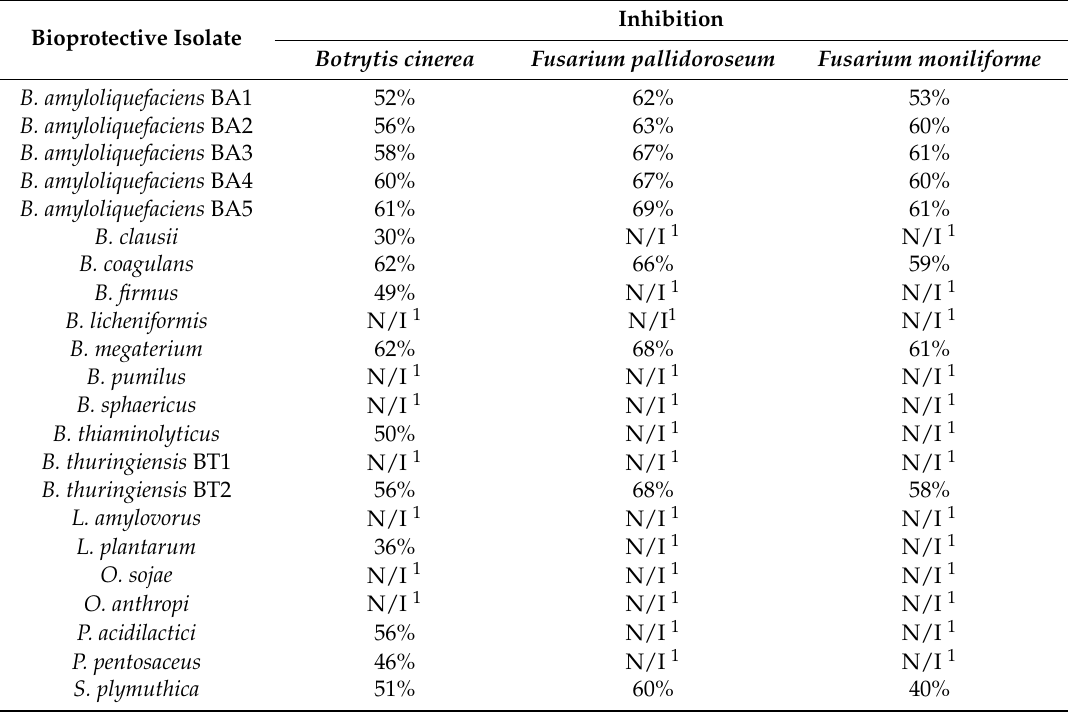
Table 2. Fungal inhibition of bioprotective isolates against Botrytis cinerea , Fusarium moniliforme , and Fusarium pallidoroseum after 10 d incubation at 24 ◦ C.